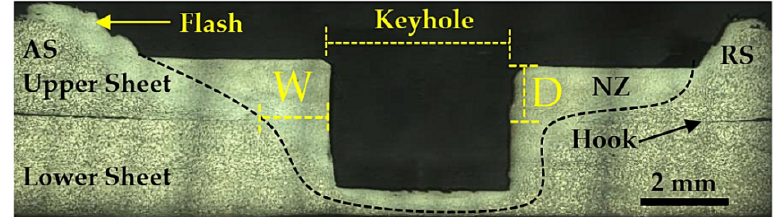
Figure 6. Micrographic of the cross-section of width and depth in NZ by FSSW of SSM6061 aluminum alloy.